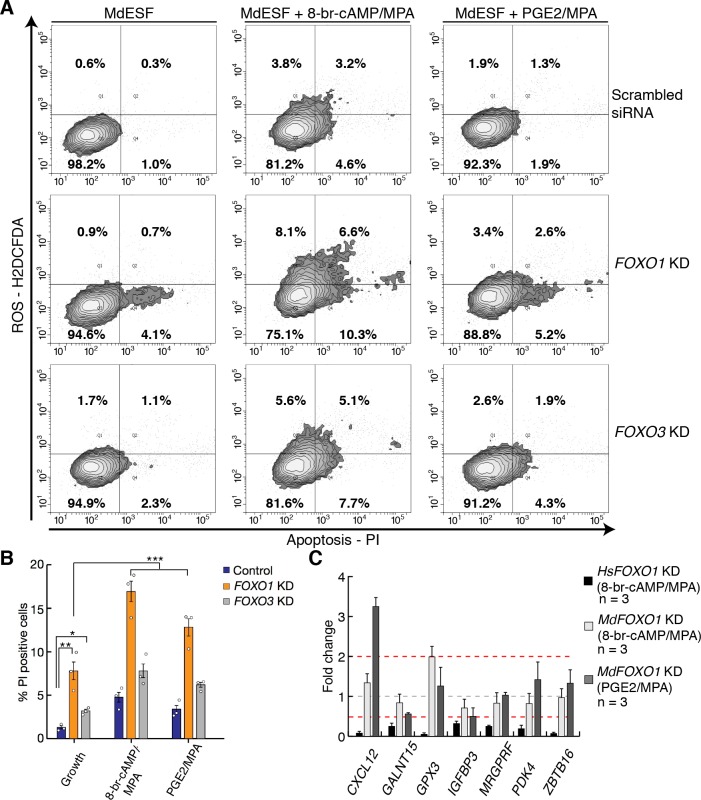
FOXO proteins counteract apoptosis in stimulated MdESF.(A) Treatment of MdESF with 8-br-cAMP/MPA or PGE2/MPA for 3 days results in more cells positive for ROS and apoptosis, PI staining (top panels). KD of FOXO1 in unstimulated MdESF increases cell counts for apoptotic cells relative to control treated with scrambled siRNA control (middle, left panel). KD of FOXO1 and treatment with cAMP/MPA or PGE2/MPA for 3 days significantly increased cell counts for apoptosis along with a moderate increase in ROS (middle panels). KD of FOXO3 in unstimulated MdESF increases cell counts for ROS and apoptosis (bottom, left panel). KD of FOXO3 and subsequent 3-day treatment with decidualizing stimuli or PGE2/MPA results in increased cell counts for ROS and apoptosis (bottom panels). Quadrants are set to maximum extent of boundaries in unstimulated MdESF treated with scrambled siRNA. Q1, positive for ROS only; Q2, positive for ROS and PI; Q3, negative for ROS and PI; Q4, negative for ROS and positive for PI. Percentage in each quadrant represents mean of three replicates. (B) Bar graph showing mean percent positive cells for quadrants 2 (ROS and PI positive) and 4 (PI positive only) (n = 3, 2-tailed t test, * p < 0.05, ** p < 0.005; ANOVA on log transformed fraction of cells, *** p = 5.91 × 10−8). Blue, scrambled siRNA control; orange, FOXO1 KD; gray, FOXO3 KD. Empty circles represent individual data points for each replicate. (C) Fold change of FOXO1-responsive genes in human DSCs in MdESF stimulated for 3 days with either 8-br-cAMP/MPA or PGE2/MPA in FOXO1 perturbation background relative to stimulated control treated with scrambled siRNA. Data are the average of three replicates ± standard error of the mean. Underlying data are provided in S1 Data. cAMP, cyclic AMP; DSC, decidual stromal cell; FOXO, forkhead box class O; KD, knockdown; MPA, medroxyprogesterone acetate; PGE2, prostaglandin E2; PI, propidium iodide; ROS, reactive oxygen species; siRNA, small interfering RNA.